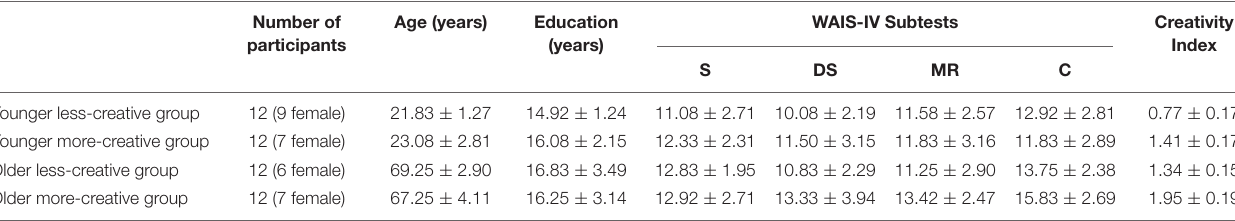
TABLE 1 | Demographic data and test scores for the four creativity groups based on age (mean and standard